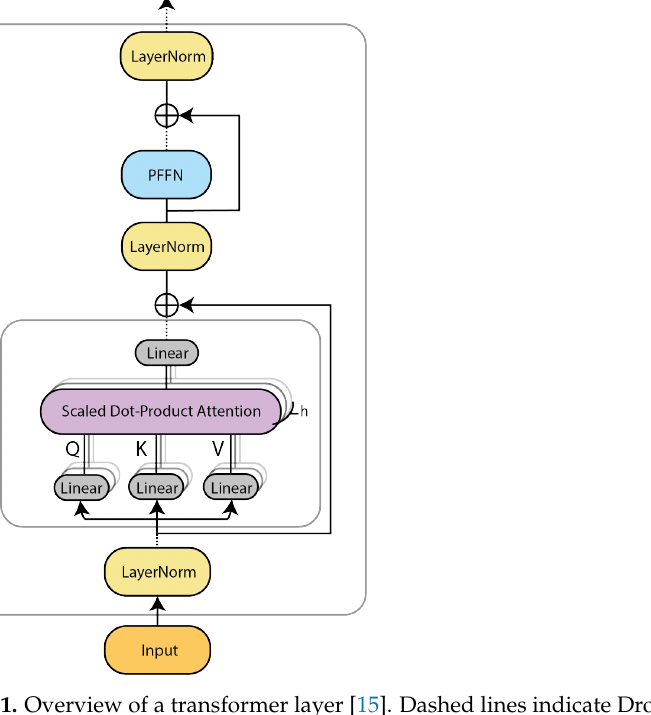
Figure 1. Overview of a transformer layer [15]. Dashed lines indicate Dropout regularization